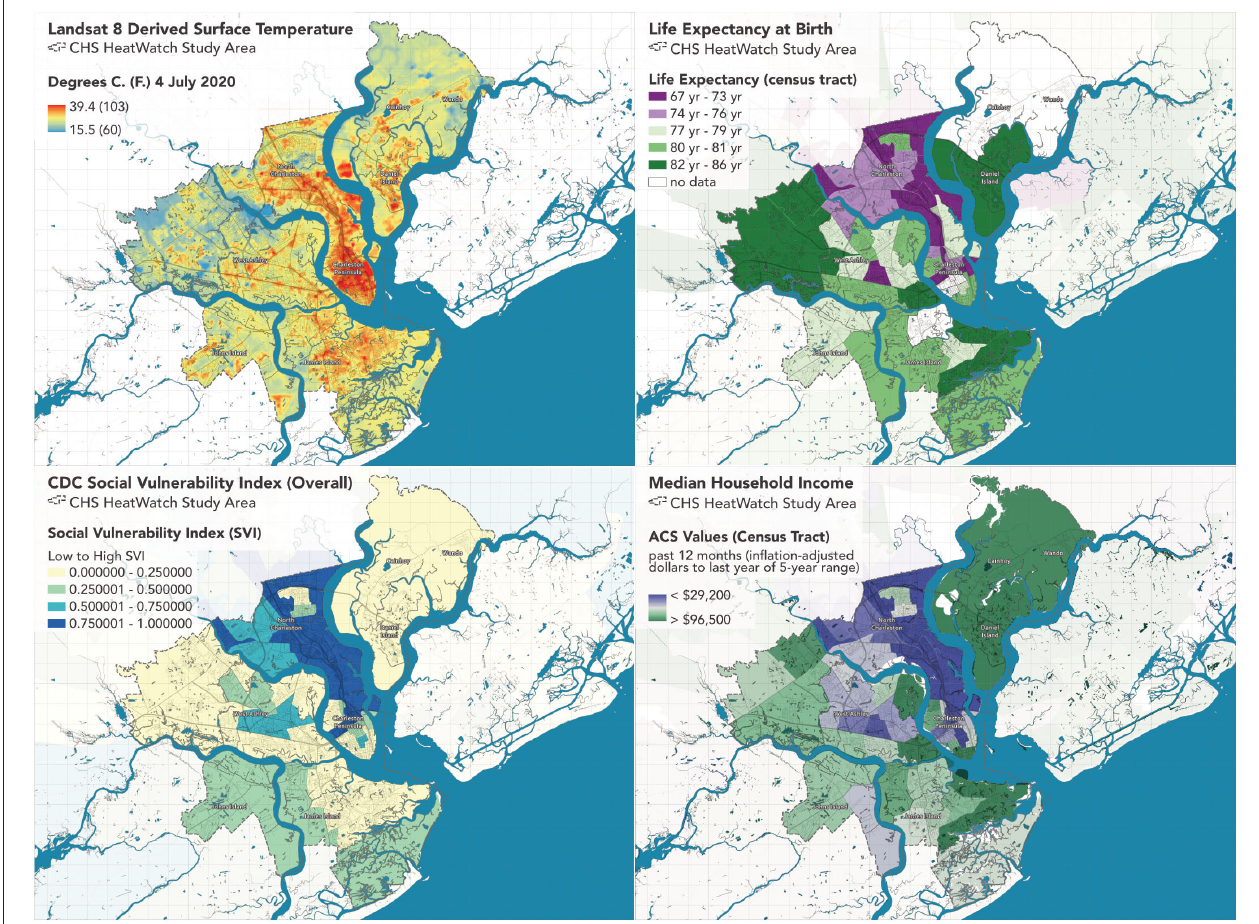
FIGURE 3 | City of Charleston Heat and social vulnerabilities